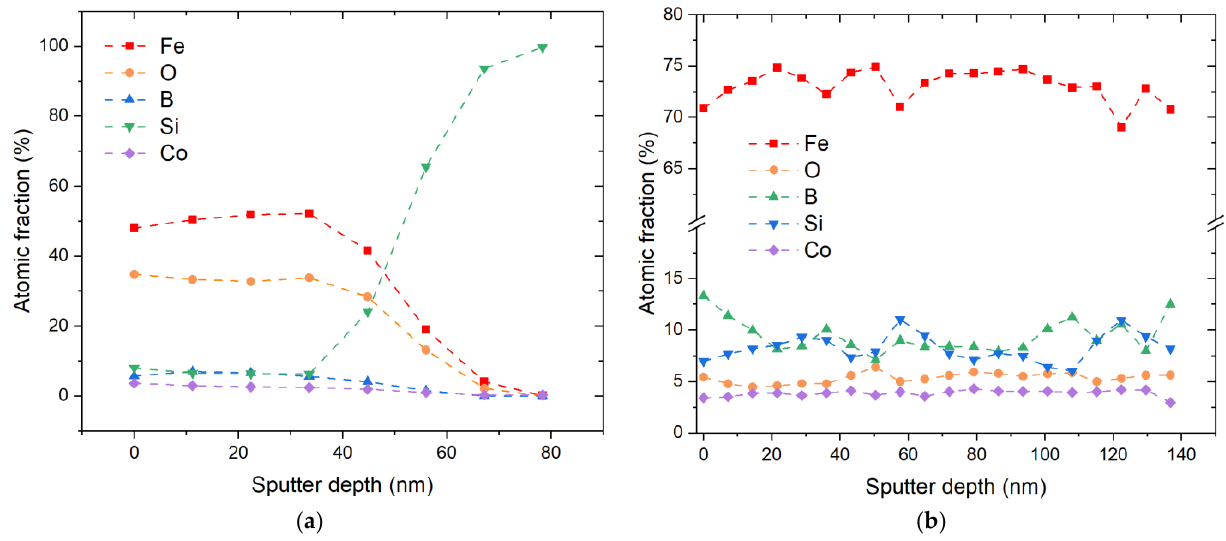
Figure 4. (Color online) Depth profile ( a ) of a 50 nm thick metglas layer on silicon, produced at the second stage of the technology improvement, and ( b ) of a 1000 nm thick sample, produced at the third stage of the technology improvement.